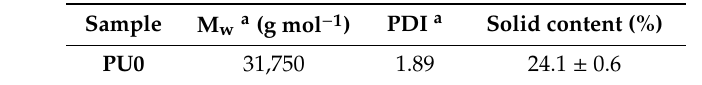
Table 1. The weight average molecular weight, M w , polydispersity index, PDI , and solid content of PU0.